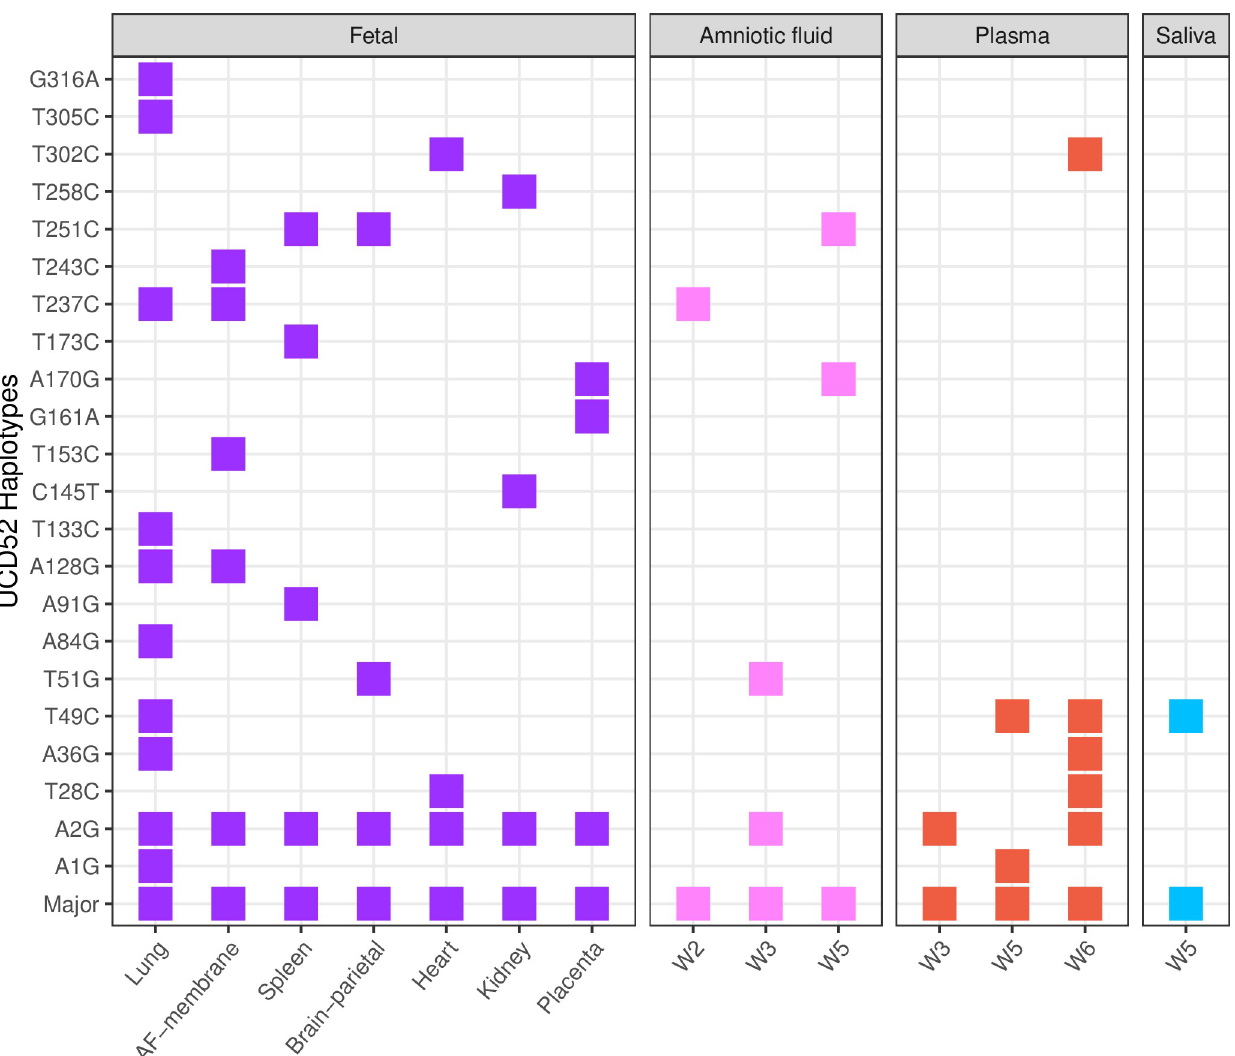
major haplotype, which is located in the bottom row. A square denotes that a given haplotype was found in a given